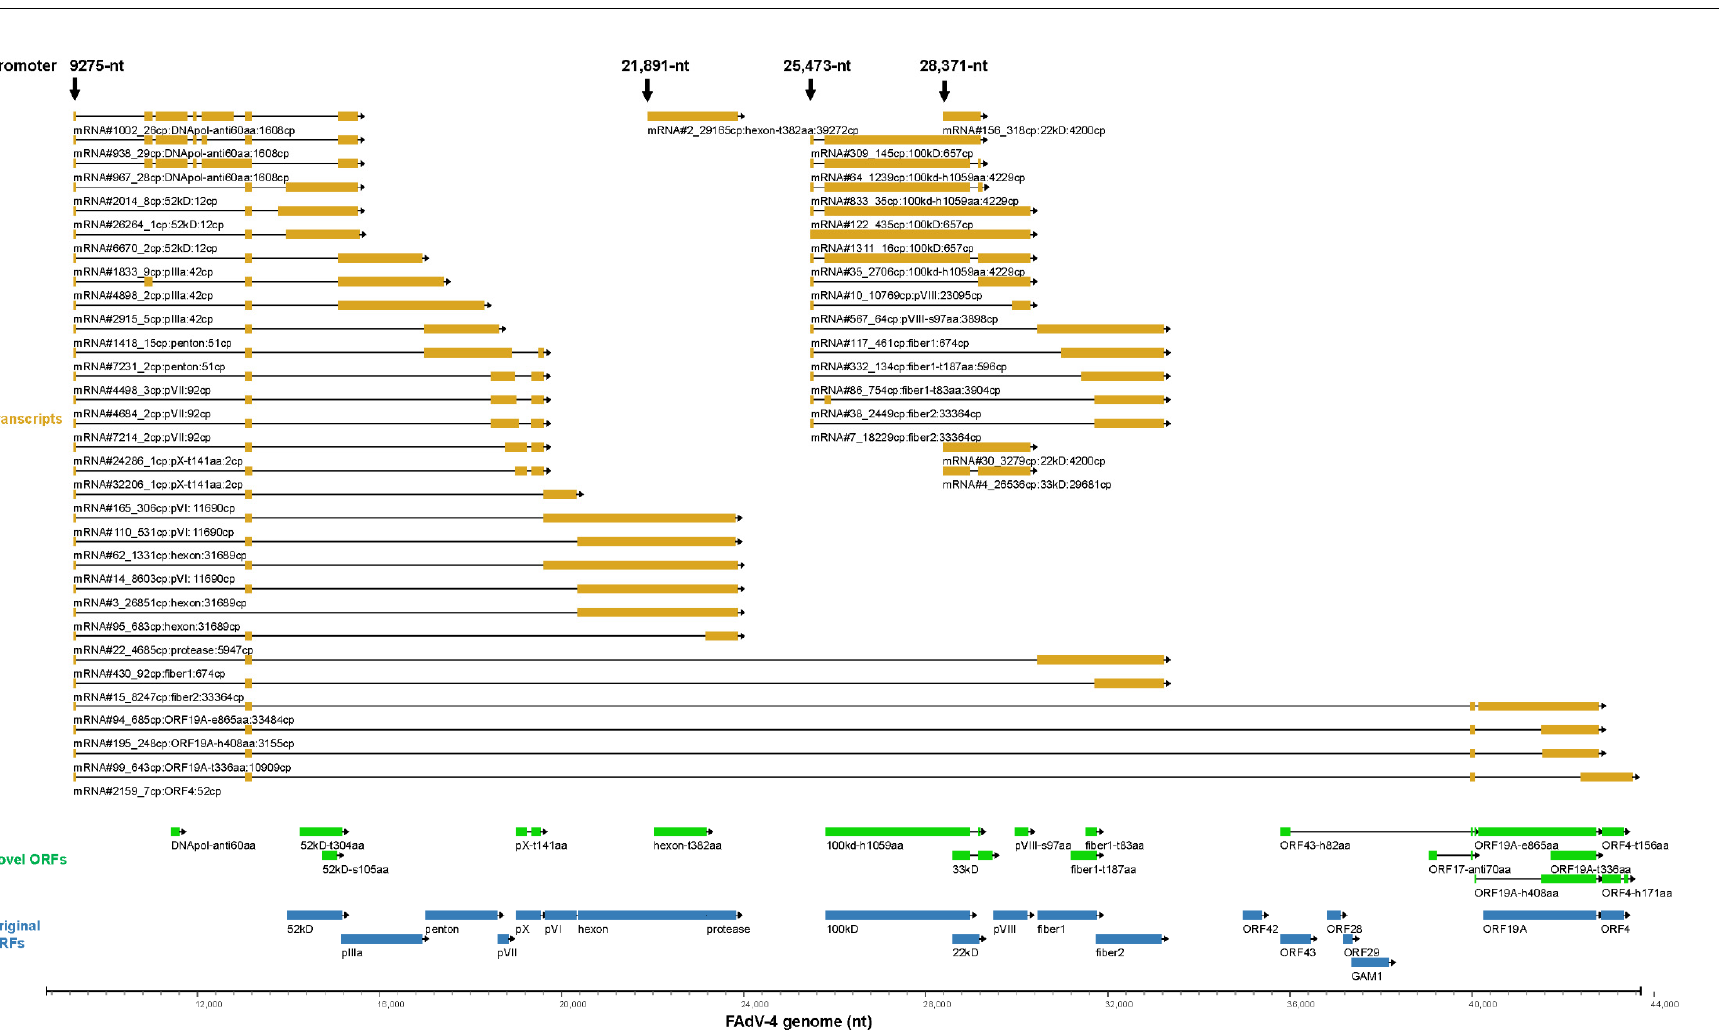
Figure 6. Key transcripts controlled by the forward 9275-nt, 21,891-nt, 25,473-nt and 28,371-nt promoters. The related annotation and explanation can be found in the legend of Figure 5.